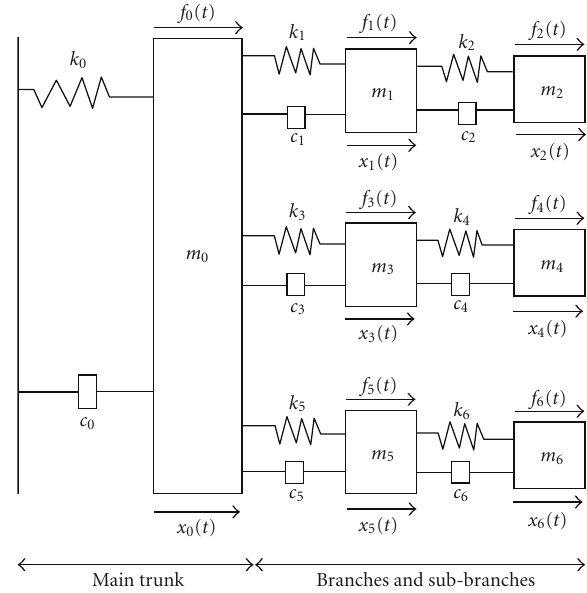
Figure 7: Dynamic representation of a tree. m i , k i , c i , f i ( t ), and x i ( t ) are the mass, spring constant, damping factor, time varying wind force, and time varying displacement of tree component i ,